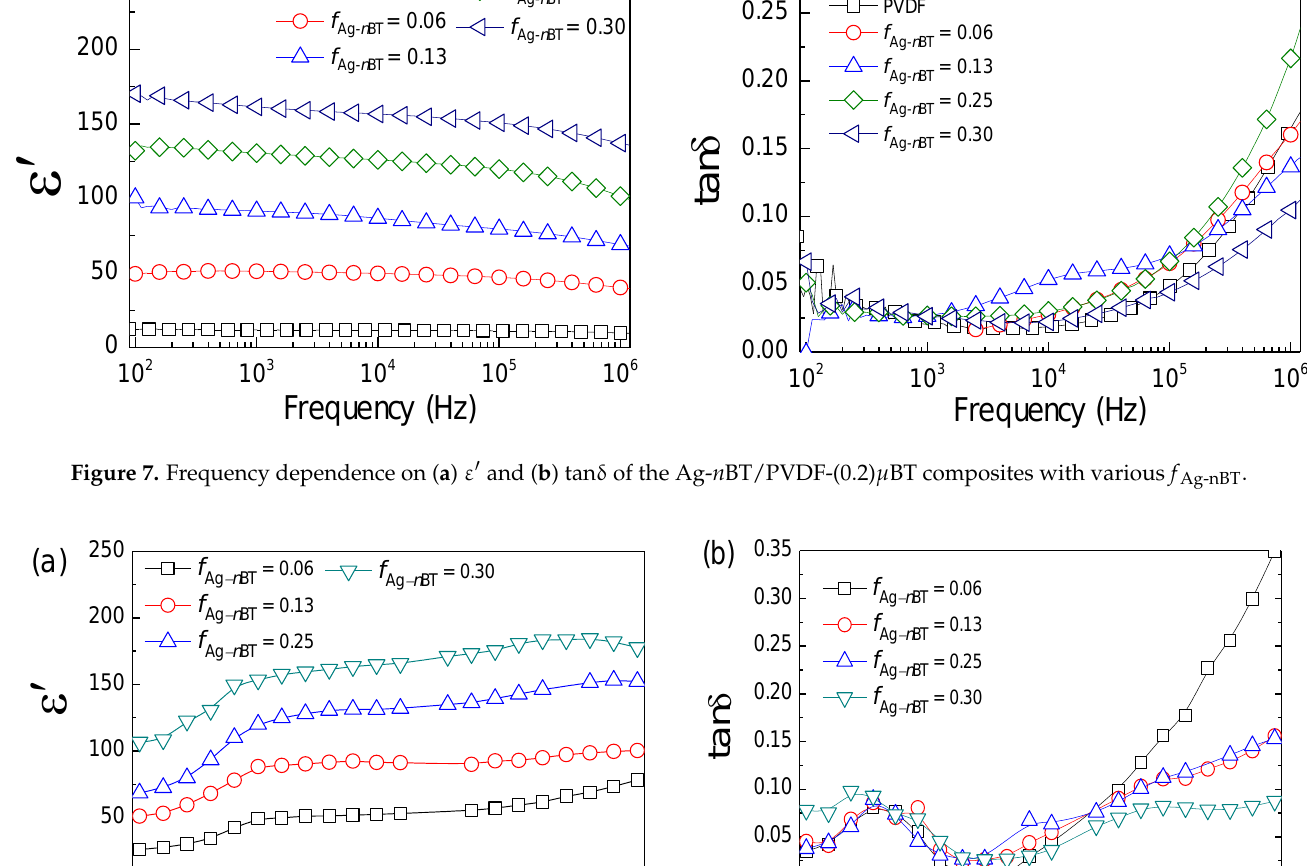
Figure 7. Frequency dependence on ( a ) ε′ and ( b ) tanδ of the Ag- n BT/PVDF-(0.2) μ BT composites with various f Ag-nBT .